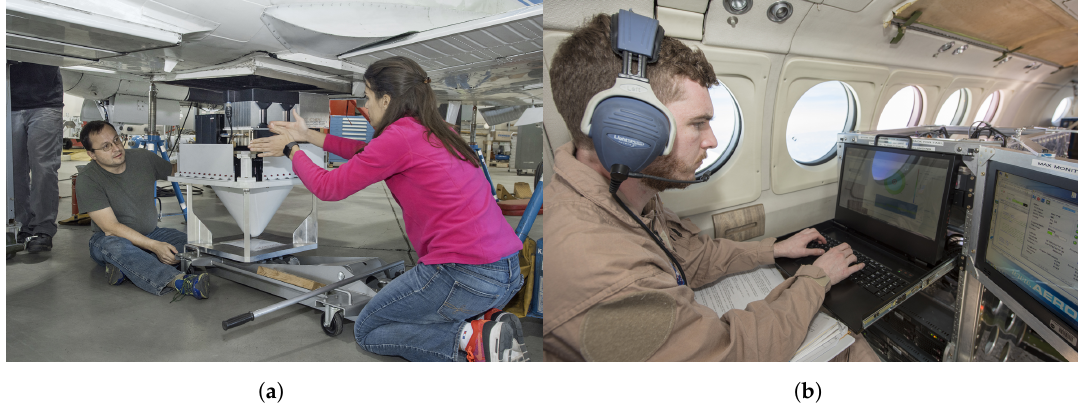
Figure 8. ( a ) DopplerScatt engineers Raquel Monje and Fabien Nicaise install the instrument into the